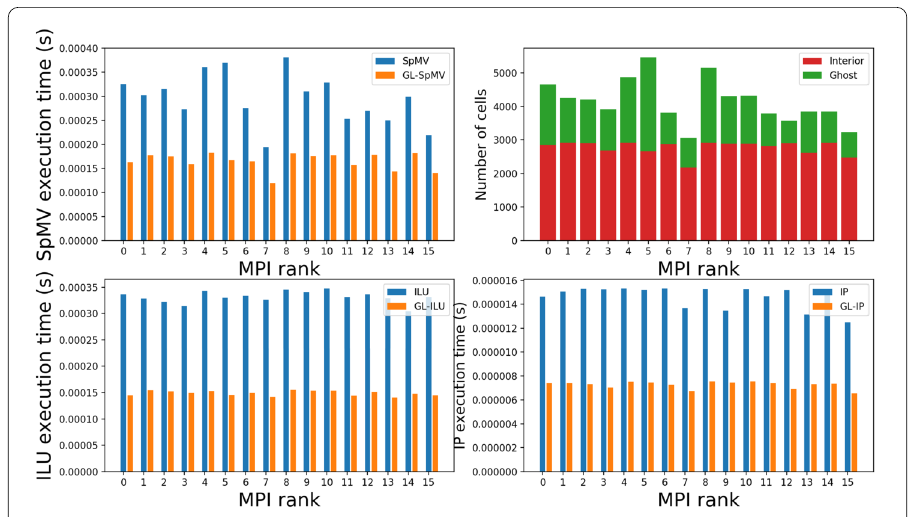
Figure 6 Per-process time usage of linear algebra kernels on an Abel node, and distribution of ghost/interior cells when the number of MPI-processes is 16